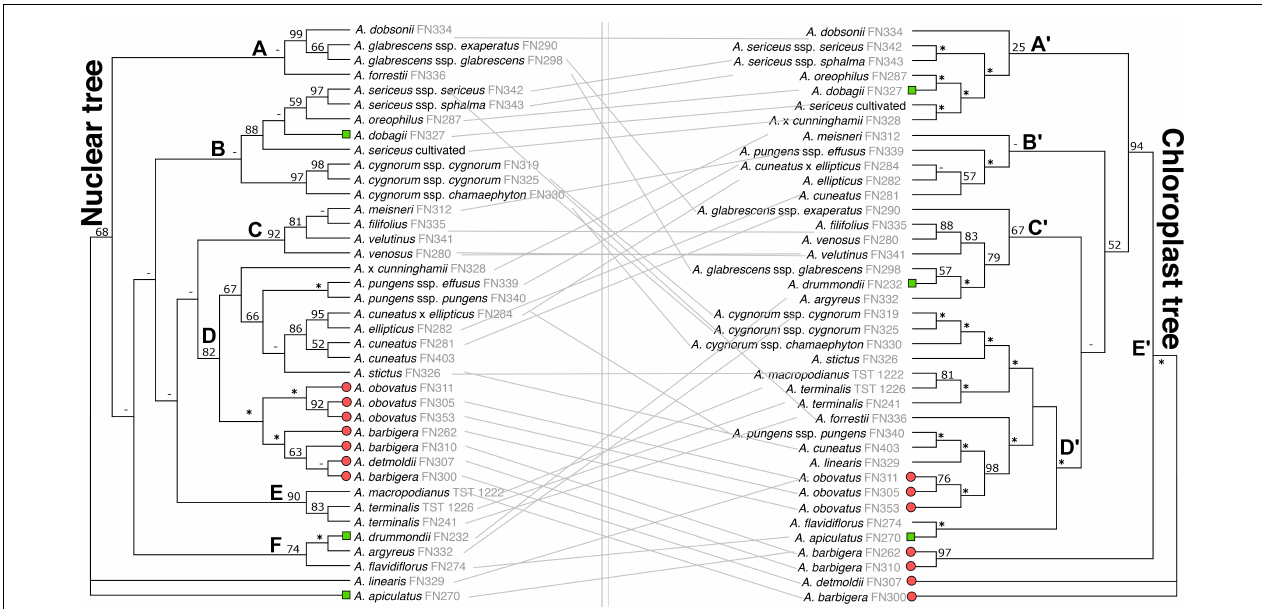
FIGURE 2 | Tanglegram comparing the phylogenetic placement of Adenanthos taxa connected by gray lines from maximum-likelihood concatenated RAxML nuclear (left) and plastid (right) trees. Bootstrap support (BS) is indicated above branches: very strongly supported clades (BS = 100%) are represented by “*”, weakly supported branches with < 50% BS are represented by “–”. Letters (A–F) and (A’–E’) refer to clades discussed in text. Terminal tips represent taxa from A. sect. Eurylaema (red circles), A. sect. Adenanthos subsect. Anaclastos (green squares), and A. subsect. Adenanthos (unlabeled).